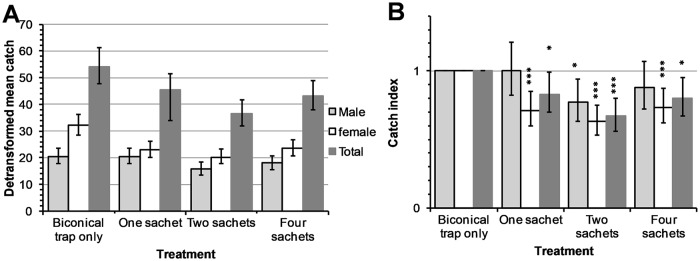
WRC dispensed from varying number of sachets at biconical traps.Detransformed means (A) and indices (B) of G. f. fuscipes catches Error bars indicate 95% CI of the detransformed mean (A) and catch index (B). *P<0.05 and ***P<0.001.